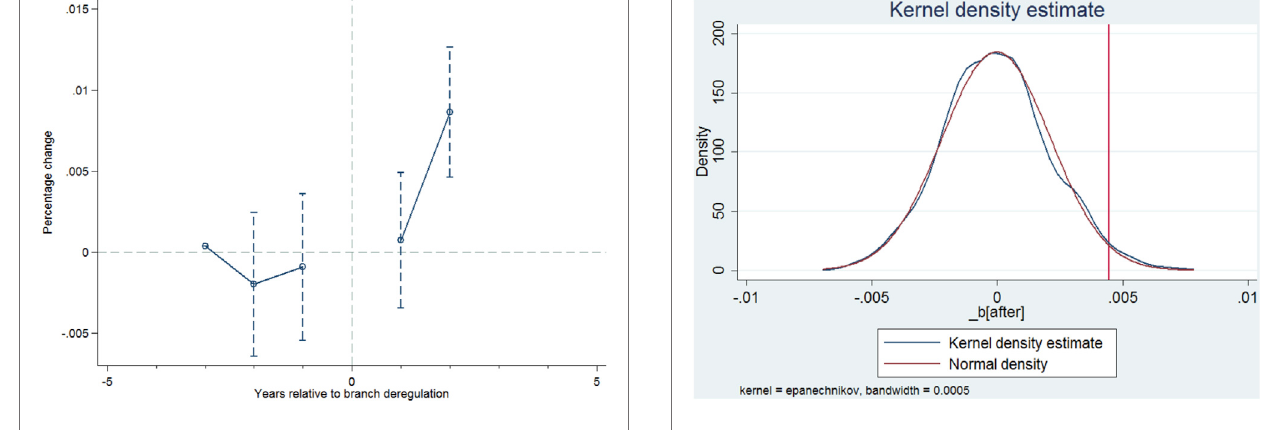
FIGURE 3 | DID balance test (1.5 column image). FIGURE 4 | DID placebo test (single column